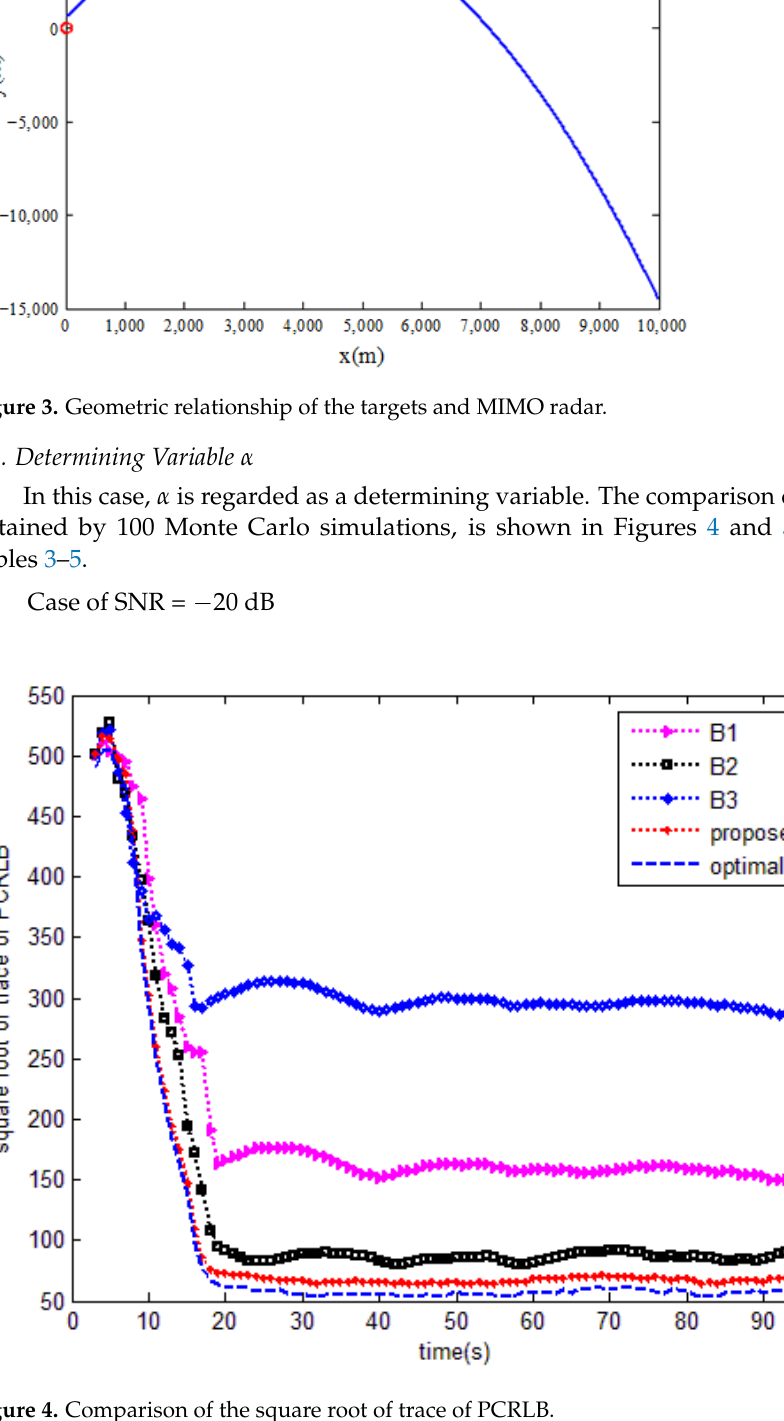
Figure 5. Computational complexity comparison. Table 3. Antenna selection of the proposed method in one trial. Time Epoch